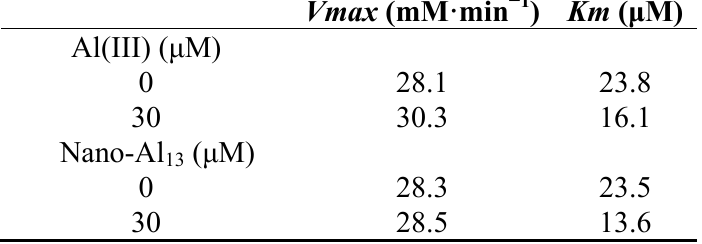
on K and V of MDH (pH 7.5, 25 13 m max